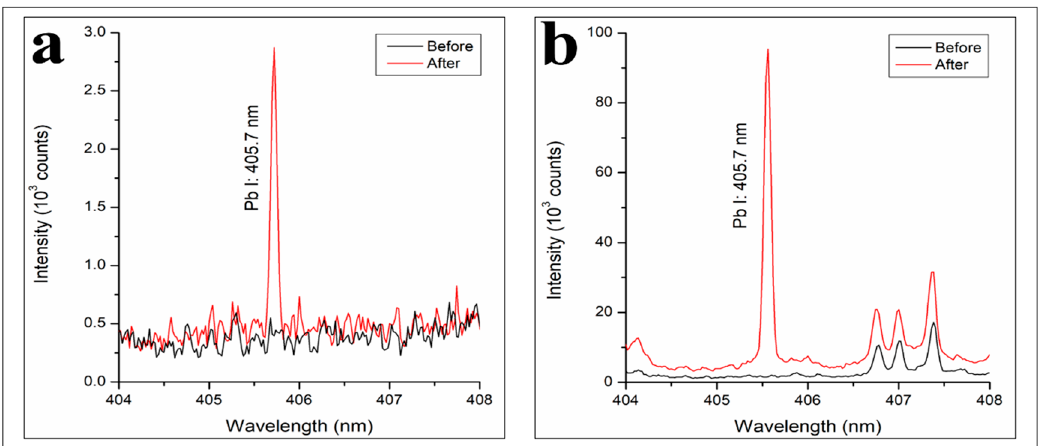
Figure 8. LIBS spectra of ( a ) COPUF and ( b ) B / COPUF before and after Pb 2 + (100 µ g / mL) adsorption, analyzed under low air pressure (3 Torr)